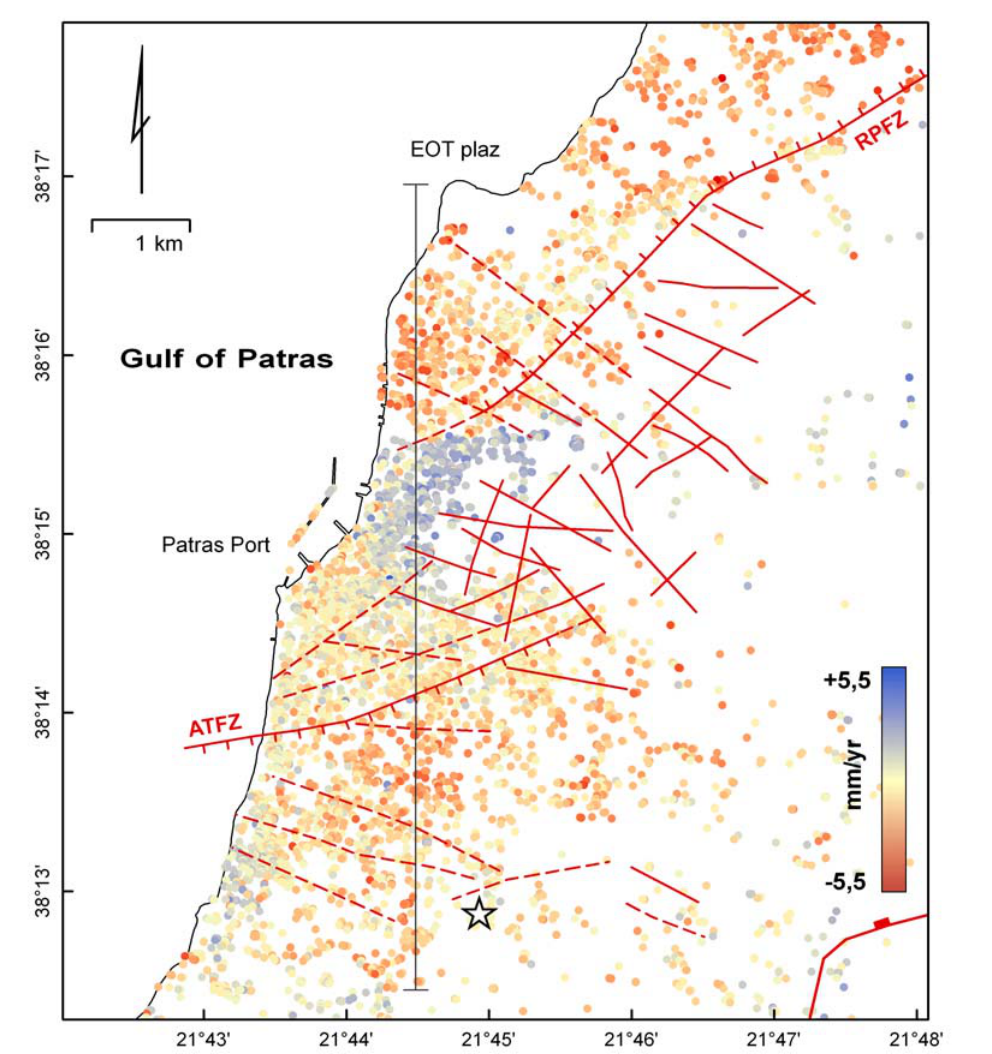
Figure 6. Point targets plotted over the fault map for Patras area (ATFZ: Ag. Triada Fault Zone), solid line corresponds to the section of figure 7, fault pattern modified from Koukis et al .